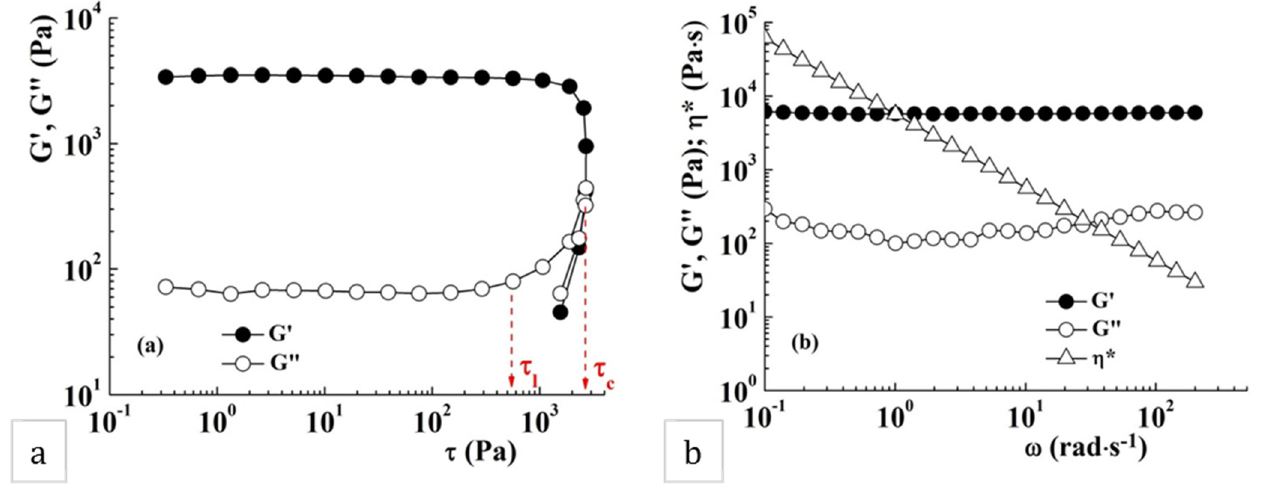
Figure 8. Viscoelastic properties of sample POD: ( a ) the linear viscoelastic range at 25 ° C and 10 rad·s − 1 ; ( b ) variation of G ′ , G ″ and η * as a function of oscillatory frequency, ω , at 25 ° C and 10 Pa.